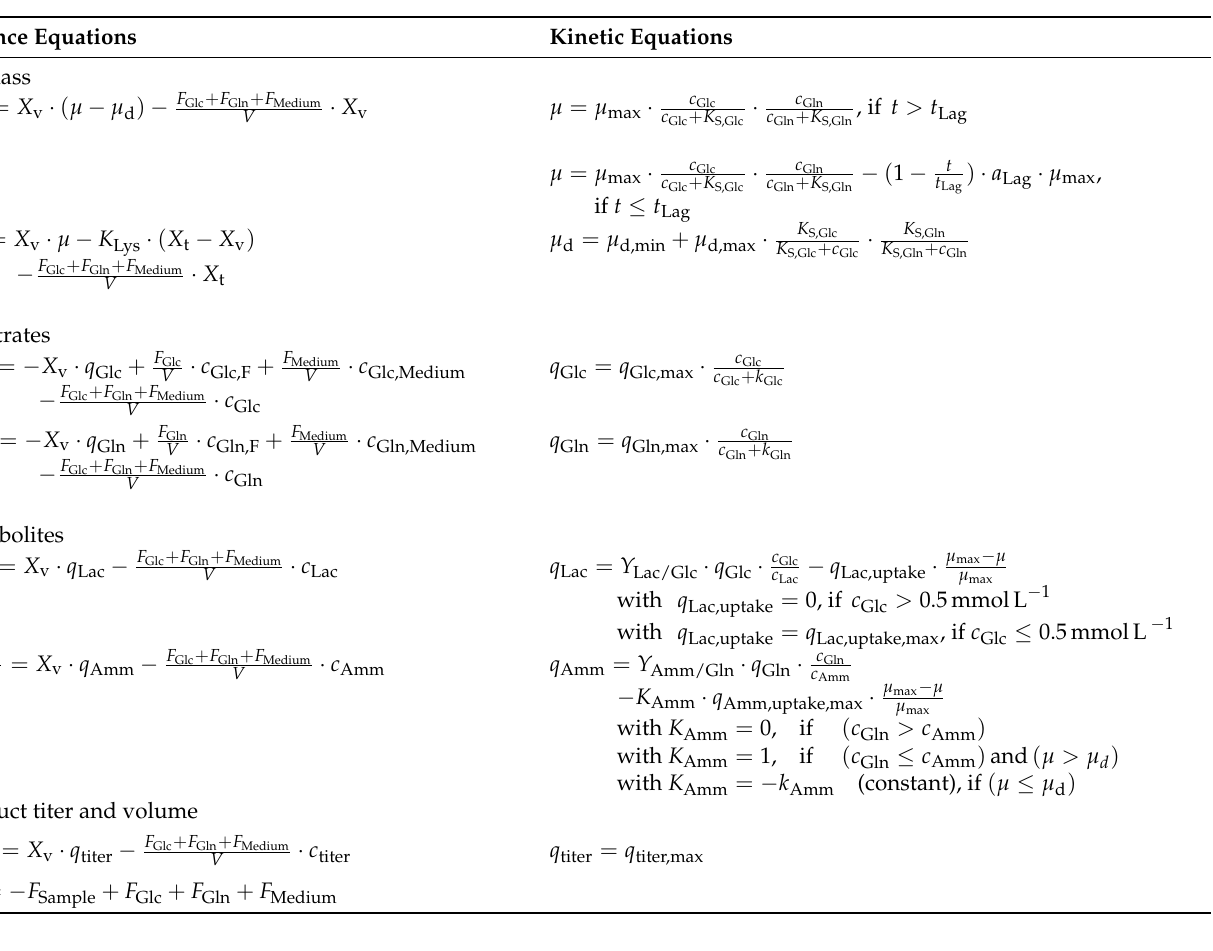
Table A1. Mechanistic model [27,42–45] for description of cell growth, cell death, substrate uptake, metabolite production and antibody production applicable to batch and fed-batch mode.